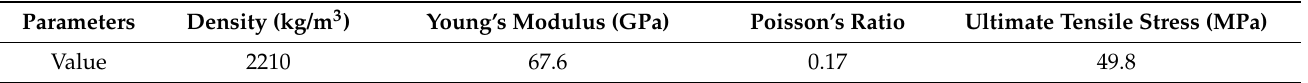
Figure 1. Geometrical and FEA models of the USOC (Ref. [19]). ( a ) The geometry model of the cavity: T is the thickness of the midplane of the USOC, and A and B represent two kinds of constraints in the FEA simulation. The diameter of the midplane is 140 mm. φ1 represents the diameters of the holes used to fix the cavity. ( b ) The FEA model of the USOC meshed with tetrahedron elements. Table 1. Material properties of ULE.